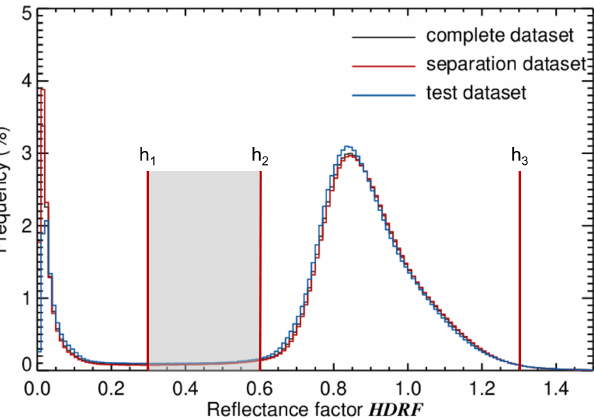
Figure 10. Same as Fig. 2 but also including the distributions of the separation data set (red) and test data set